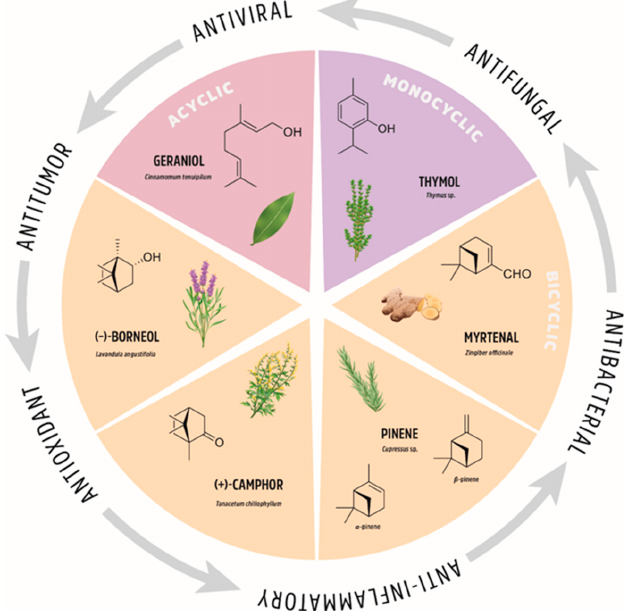
Figure 2. The natural origin of monoterpenes and their biological applications.